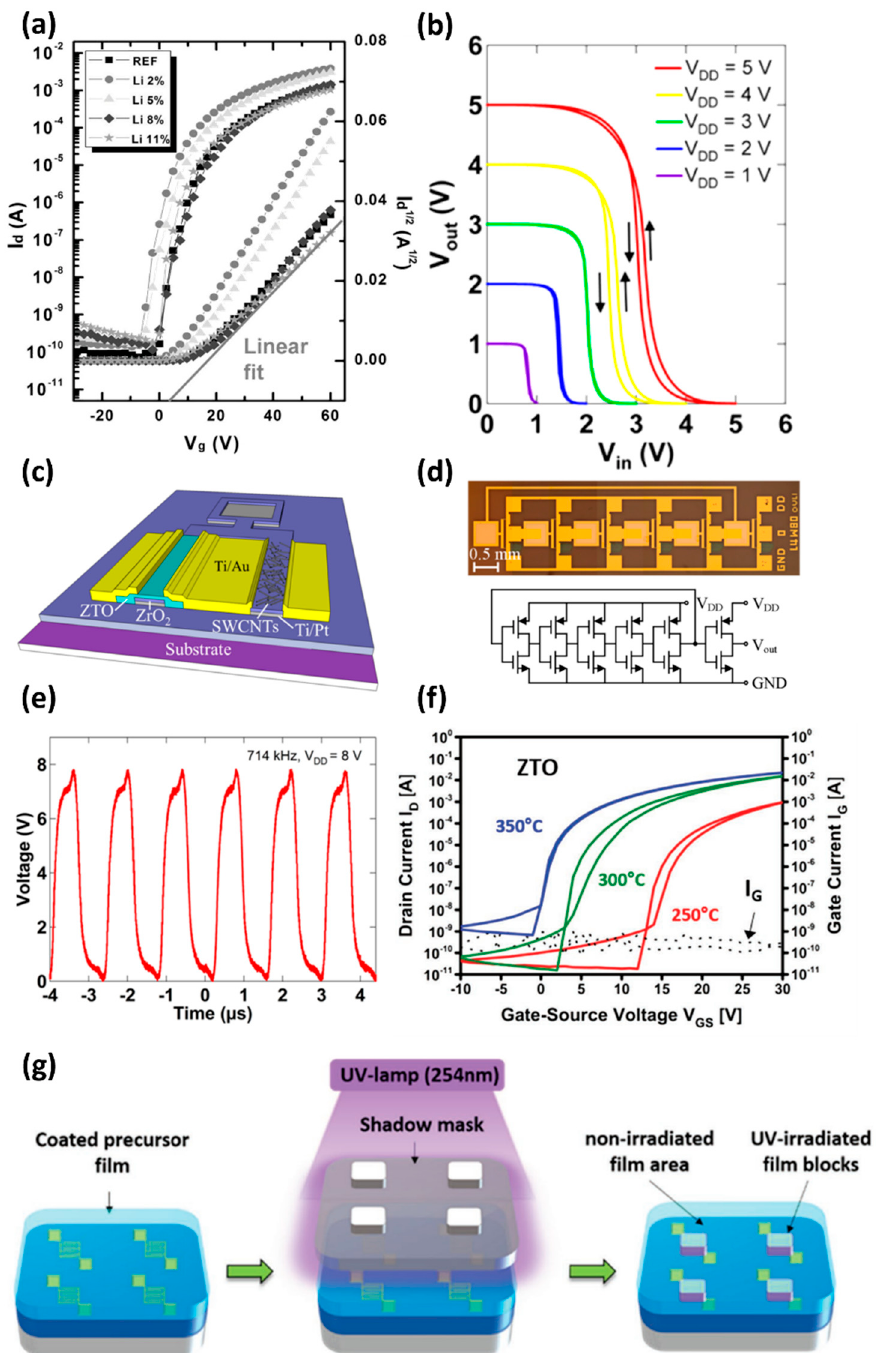
Figure 2. ( a ) Transfer characteristics of the pristine ZTO TFT and Li-doped ZTO TFTs at various Li doping concentrations (adapted from [58] with permission from John Wiley and Sons). ( b ) Characteristic curve of inverter circuit manufactured by combining ZTO TFT and SWCNT TFT. ( c ) The structure of an inkjet-printed ZTO and SWCNT-based complementary inverter. ( d ) Circuit optical image and diagram of a five-stage ROSC. The last inverter is a buffer stage. ( e ) The output of a fabricated ROSC operating at 714 kHz input (adapted from [60] with permission from the American Chemical Society). ( f ) Transfer characteristics for the photopatterned ZTO-based TFT after final thermal annealing at various temperatures. ( g ) Schematic illustration of the direct UV photoprocessing on a semiconducting layer (adapted from [61] with permission from John Wiley and Sons).